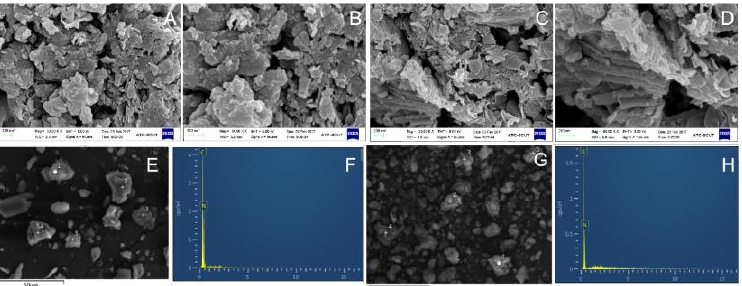
Figure 4. SEM images of ( A ), ( B ) g-C 3 N 4 and ( C ), ( D ) N D -g-C 3 N 4 , EDS spectra of ( E ), ( F ) g-C 3 N 4 and ( G ), ( H ) N D -g-C 3 N 4 . N D -g-C 3 N 4